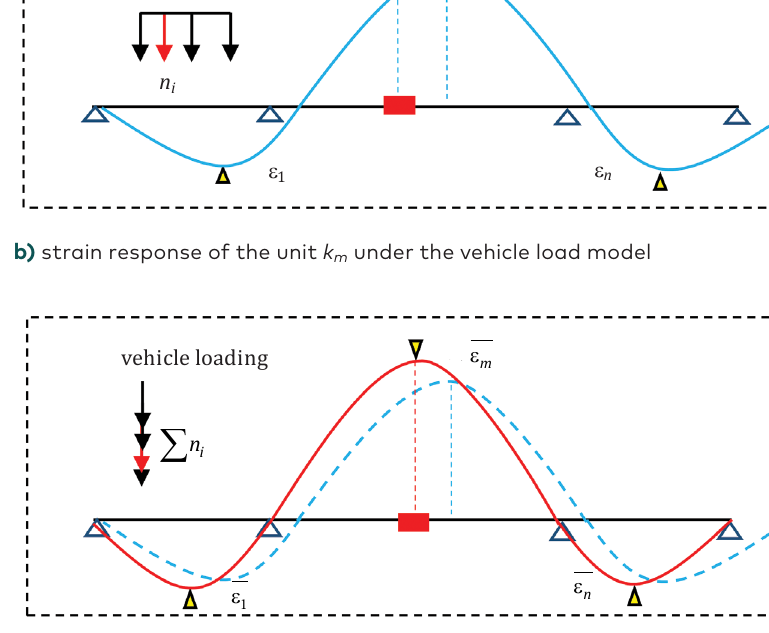
Figure 3. Analysis of the structural responses induced by different loading